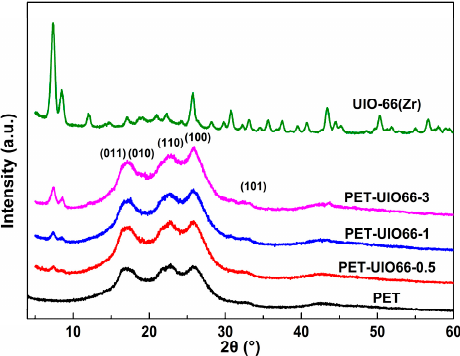
Figure 5. XRD pattern of the UIO-66, the PET and the PET/UIO-66 nanocomposites.